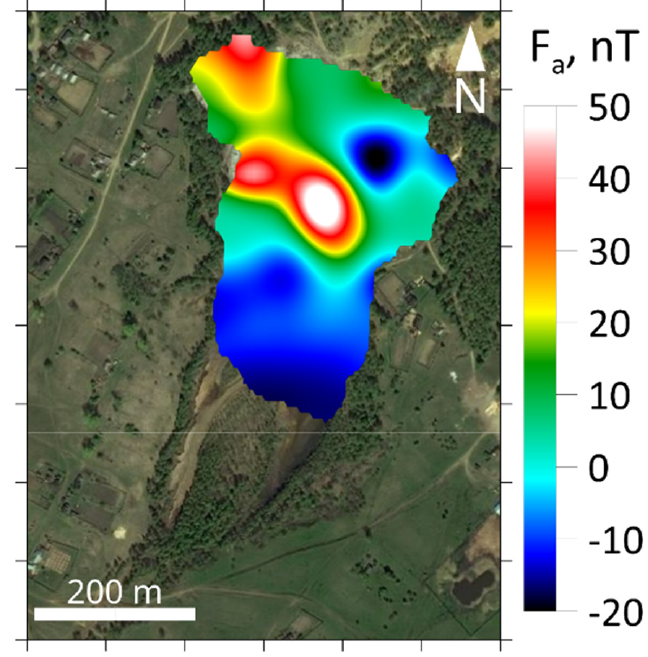
Figure 8. Anomalies of the magnetic induction vector modulus in the studied area.